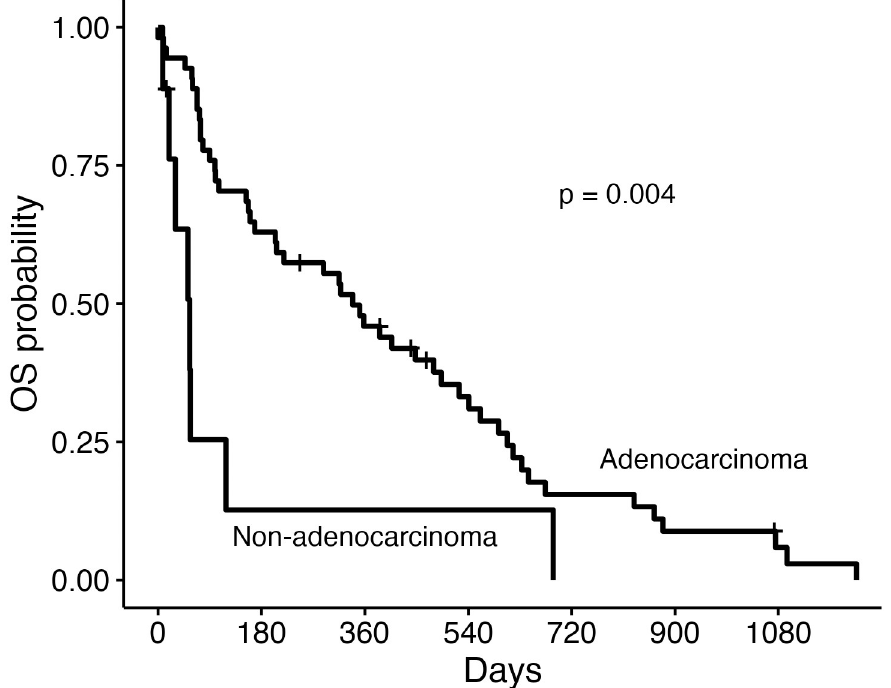
Fig 4. Overall median survival time for dogs with primary lung adenocarcinoma or non-adenocarcinoma following surgical resection. Overall survival (OS) curves for 65 dogs based on broad histologic classification of adenocarcinoma or non-adenocarcinoma. Ticks represent dogs censored from analysis. Dogs were censored if they were alive at the time of last follow-up. The median overall survival time (OST) for dogs with adenocarcinoma was 339 days (95% confidence interval [CI]: 204–524 days) while the median OST for dogs with tumors other than adenocarcinoma was 55 days (CI: 30-not reached). https://doi.org/10.1371/journal.pone.0256139.g004 Increasing mitotic index significantly decreased DFS (HR 1.03; CI: 1.009–1.060; p = 0.008). Increasing total score also significantly decreased DFS (HR 1.14; CI: 1.005–1.290; p = 0.042). Other histologic features were not significantly associated with outcome.